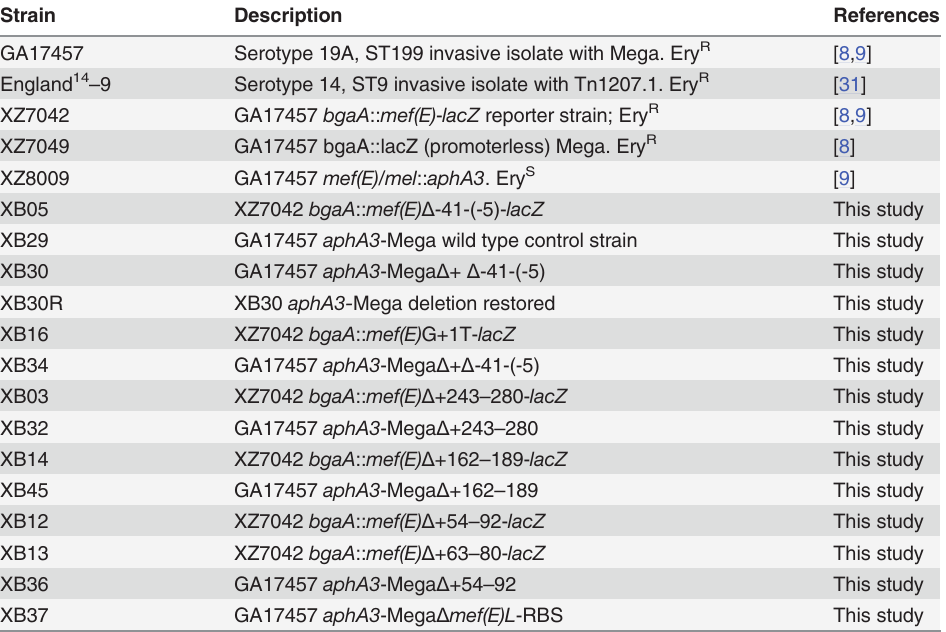
Table 1. Strains used in this study. Strain